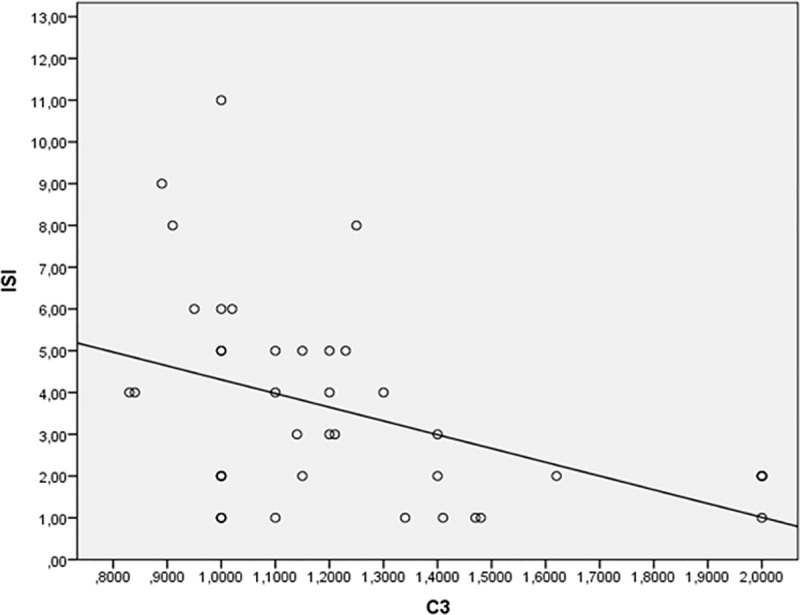
Linear regression of C3 predicting ISI.